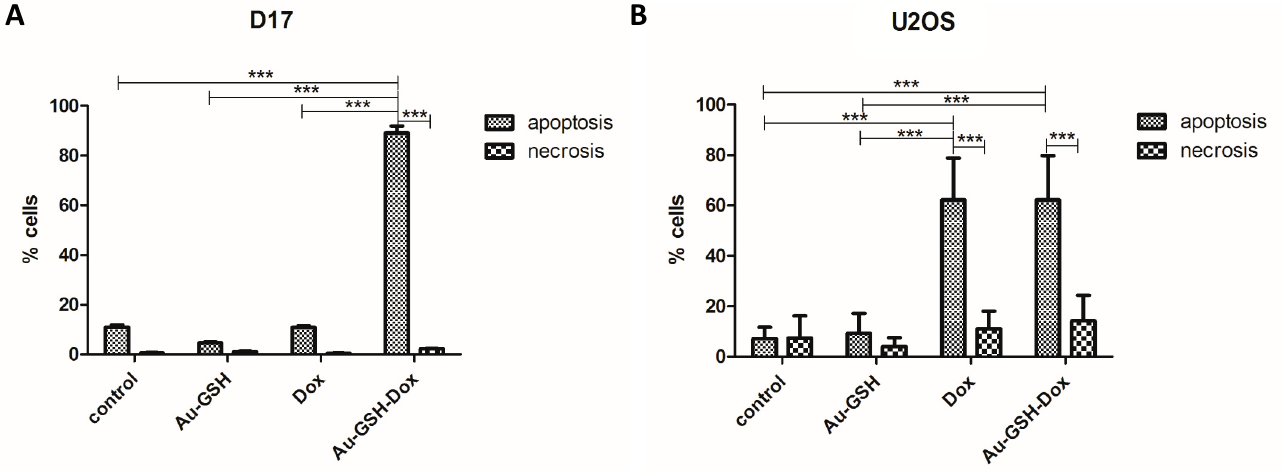
Figure 2. Statistical analyses of the percentage of cells in apoptosis and necrosis measured with annexin-V and PI assay on D17 ( A ) and U2OS ( B ) cell lines treated with Au-GSH-Dox and Dox in an IC 50 Au-GSH-Dox dose measured with the MTT assay. *** p ≤ 0.001 was interpreted as highly significant.